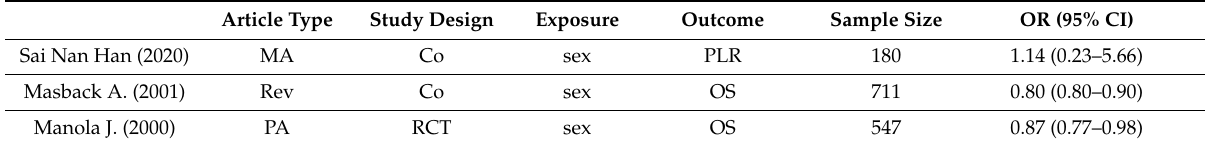
Table 3. Characteristics of studies investigating prognostic